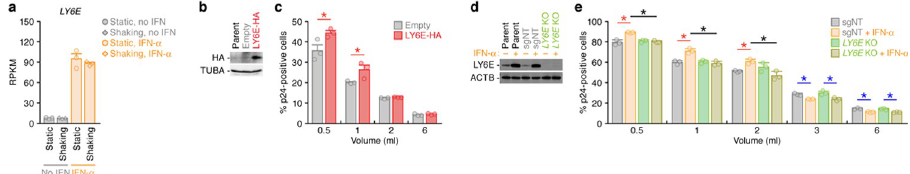
Fig 7. Contribution of LY6E to the enhancement of cell-free HIV-1 infection. a The expression levels of LY6E . Each symbol indicates the result from one replicate, and the bars with error bars indicate the averages with SEMs of three independent replicates. RPKM, reads per kilobase of exon per million mapped reads. b,c Effect of LY6E overexpression on cell-free HIV-1 infection. b Western blotting. Parental Jurkat-CCR5 cells (’Parent’), empty vector-transduced cells (Empty), and LY6E-HA-transduced cells (’LY6E-HA’) were prepared as described in Methods, and the LY6E-HA expression is detected by Western blotting. A representative result is shown. Alpha-tubulin (TUBA) is used as an internal control. c Single-round infection assay under different density conditions. The V/C at different five culture conditions (0.5, 1, 2, and 6 ml) corresponds to that shown in Fig 3A . Single round infection assay was performed at four different cell-virus densities. d,e Effect of LY6E KO on cell-free HIV-1 infection. d Western blotting. Parental Jurkat-CCR5 cells (’Parent’), non-target sgRNA-transduced cells (’SgNT’), and LY6E KO cells ( ’LY6E KO’) were prepared as described in Materials and Methods, and endogenous LY6E expression is detected by Western blotting. A representative result is shown. TUBA is used as an internal control. e Single-round infection assay under different density conditions. The V/C at different five culture conditions (0.5, 1, 2, 3 and 6 ml) corresponds to that shown in Fig 3A . Single round infection assay was performed at five different cell-virus densities. In panels c and e , each dot indicates the result from one culture, and three independent experiments were performed. The bars with error bars are the averages and SEMs of three independent experiments. Asterisks indicate statistically significant differences determined by Student’s t test ( p <